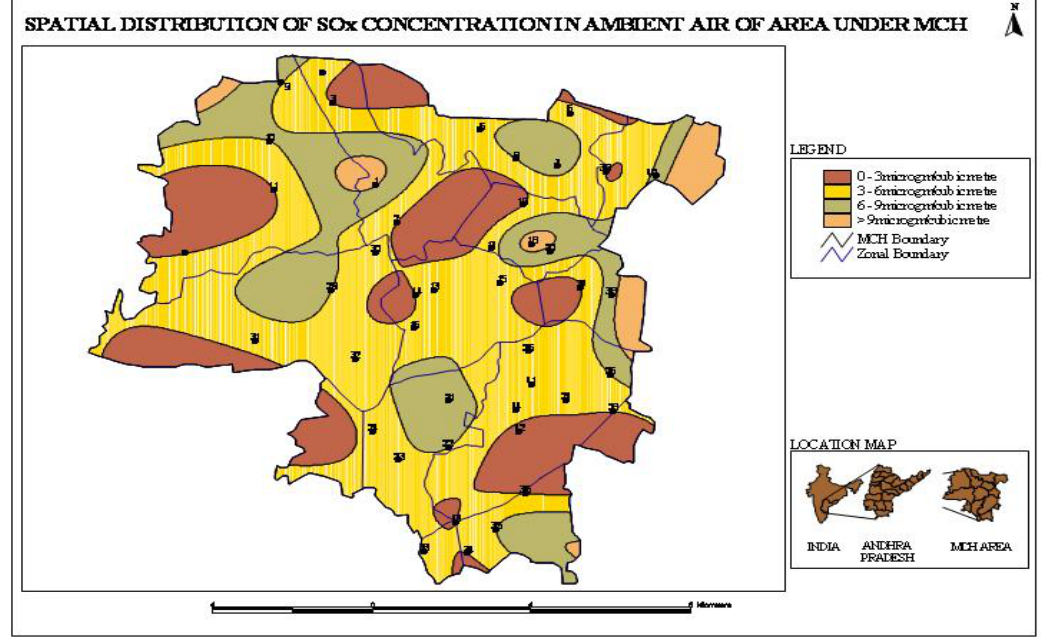
Figure 5: Spatial distribution of sulfur dioxide concentration in ambient air of